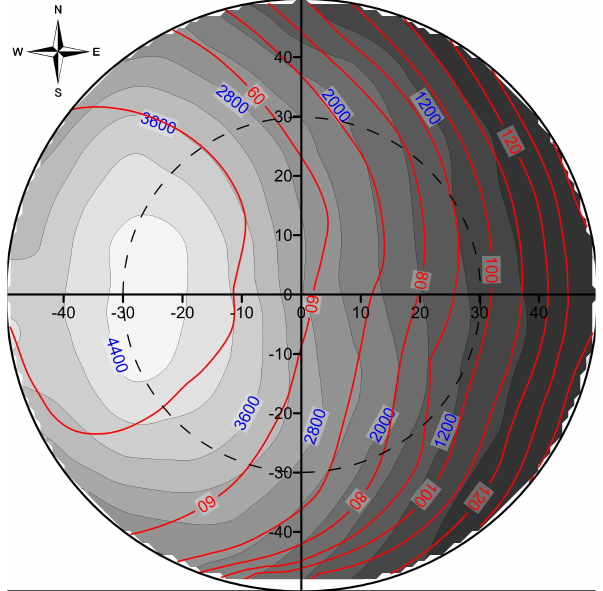
Fig. 8. The muon tomograph at K˝ob´anya, 2meters away from the axis of a blowhole. Solid red lines show the integrated lengths in the given direction, while the shading shows the measured muon flux in sr − 1 day − 1 units.